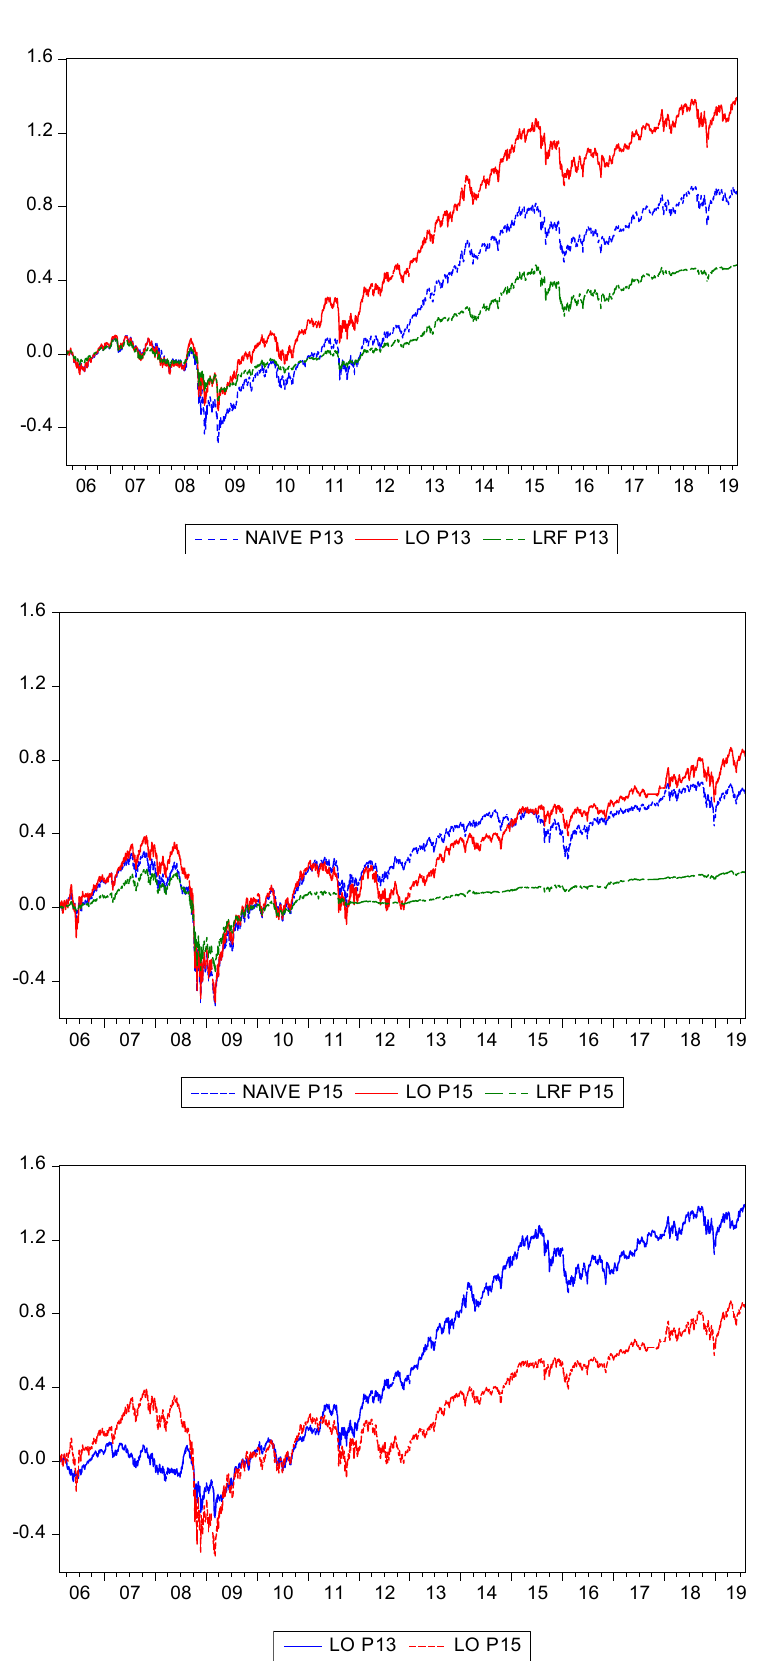
Figure 1. Cumulative returns for socially responsible investment (SRI) and vice exchange traded funds (ETFs) using different strategies.